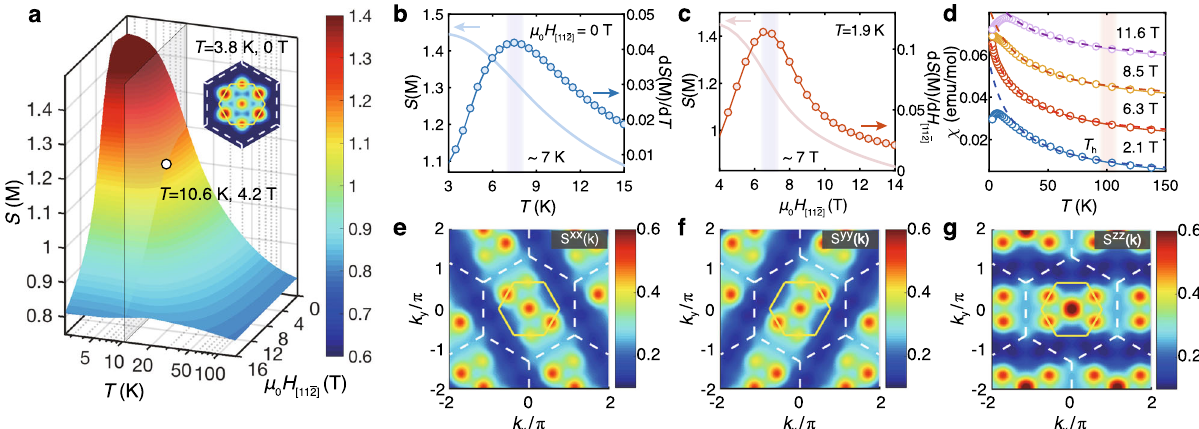
-- k a. a Surface plot of the M-point spin ½ 11 2 (cid:3) ’ 7 T. d Shows the emergent Curie-Weiss behavior in the magnetic ½ 11 (cid:1) 2 (cid:3) H ½ 11 (cid:1) 2 (cid:3) ¼ 2.1, 0 H : 2 T and T = 10.6 K, rotate ½ 11 (cid:1) 2 (cid:3) ¼ 4 0